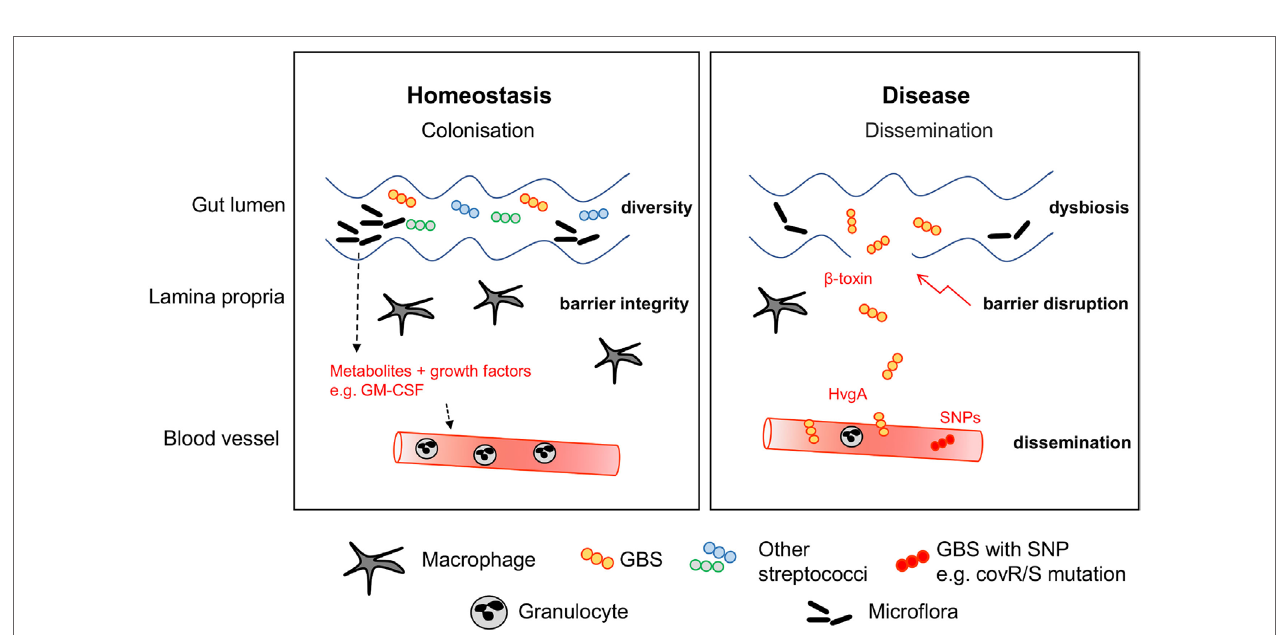
FiGURe 2 | Stabilization of the mucocutaneous niche. During homeostasis, GBS colonizes the intestine of healthy infants. Macrophages and other immune cells guarantee barrier integrity by surveillance. Other commensal bacteria including streptococcal species form the niche. Disease can be preceded by multiple factors leading to dysbiosis, expansion of GBS and barrier disruption. Expression of virulence factors such as HvgA and β -toxin facilitate adhesion to epithelial cells and barrier disruption. Dissemination is often concurrent with mutations of the CovR/S virulence